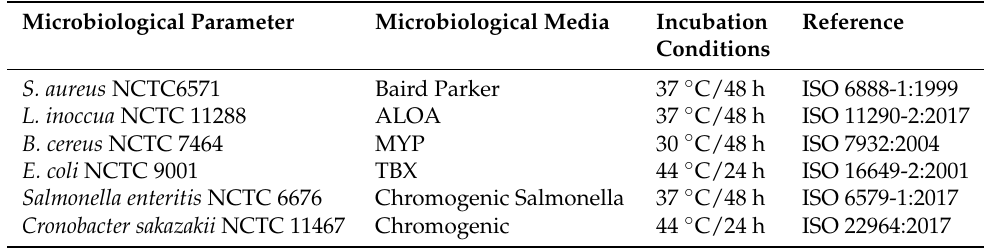
Table 1. Bacterial growth conditions.